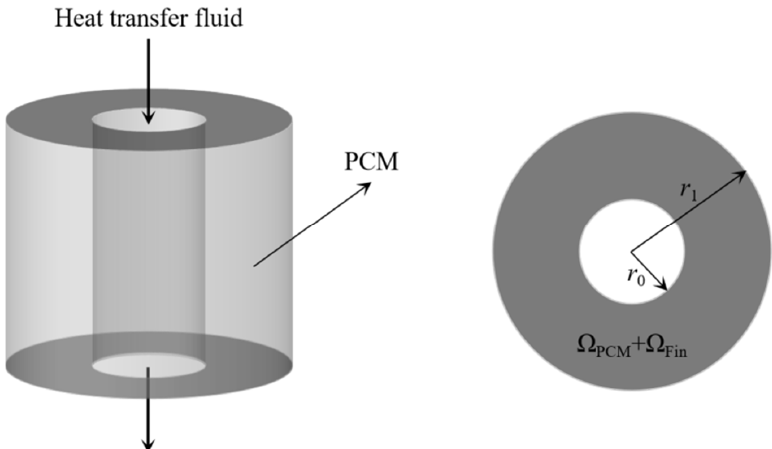
Figure 1. 3D and 2D schematic diagrams of thermal energy storage unit.